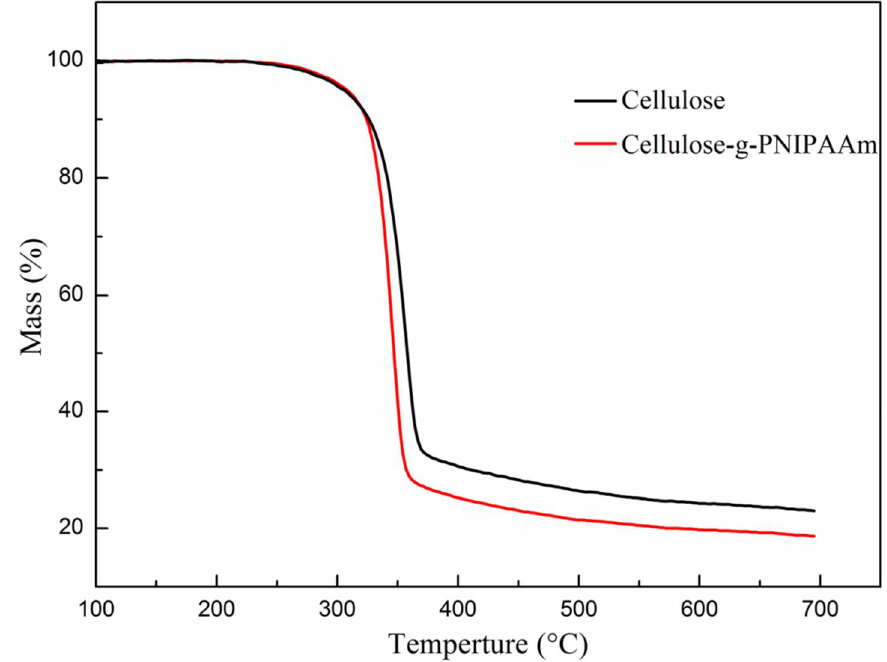
Figure 5. The thermal stability of the cellulose and cellulose- g -PNIPAAm